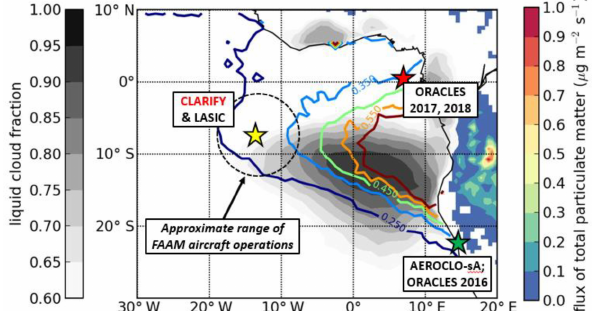
Figure 1. 2003–2011 mean August–October AODs at 550nm (coloured contours) retrieved from the MODIS satellite, MODIS cloud fraction (black and white colour scale), and Global Fire Emis- sions Dataset (GFED) aerosol emission estimates (colours over land). The yellow star shows the position of Ascension Island, with a dashed circle representing the approximate operating range of the FAAM aircraft. The position of São Tomé, where ORACLES op- erations were performed, and Walvis Bay, where both ORACLES and AEROCLO-sA operations were performed, is marked by red and green stars